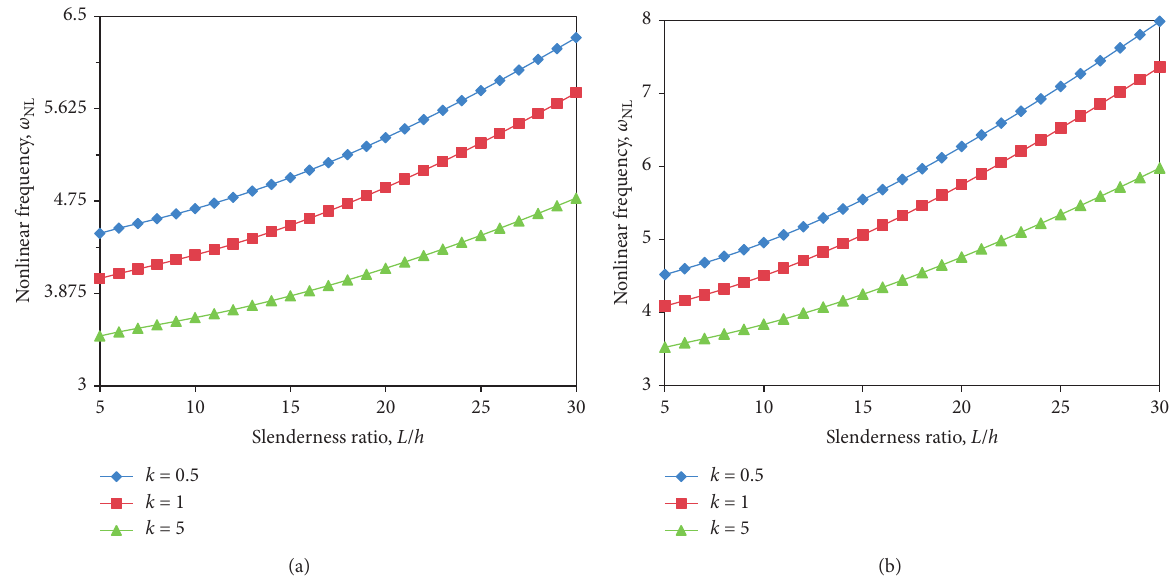
Figure 12: The variation of the nonlinear frequencies of the FG nanobeams to the slenderness ratio for β � 0 . 01, c � 10, and V without thickness effect; (b) with thickness